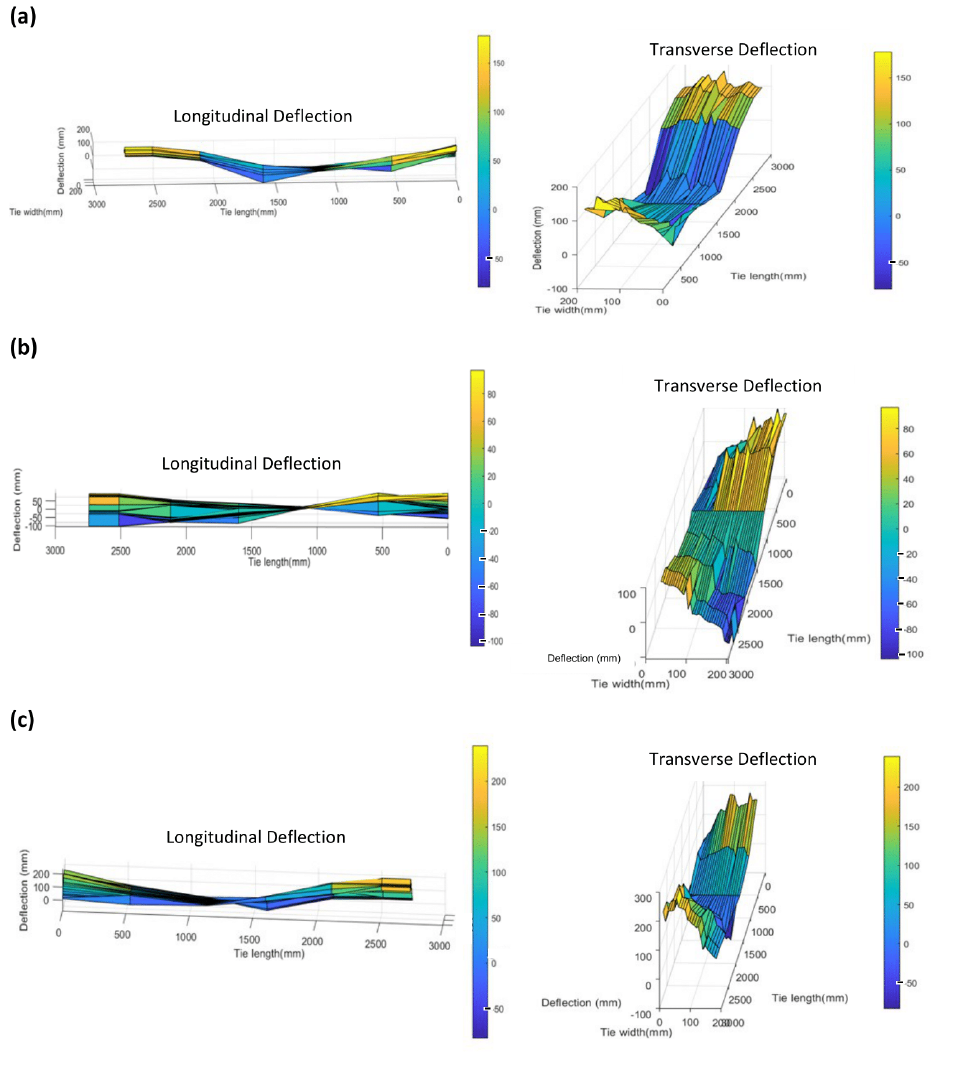
Figure 17. Longitudinal and transverse deflection profiles of three different ties with deflections scaled by 20 × : ( a ) Tie I, ( b ) Tie II and ( c ) Tie